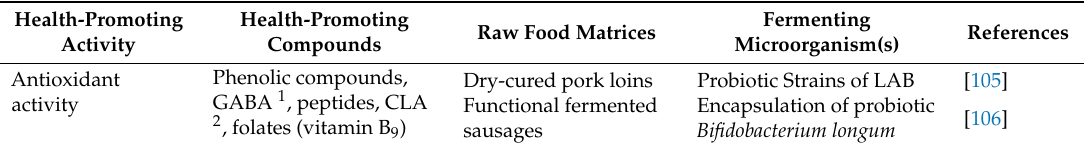
Table 5. Health-promoting compounds in fermented meat and